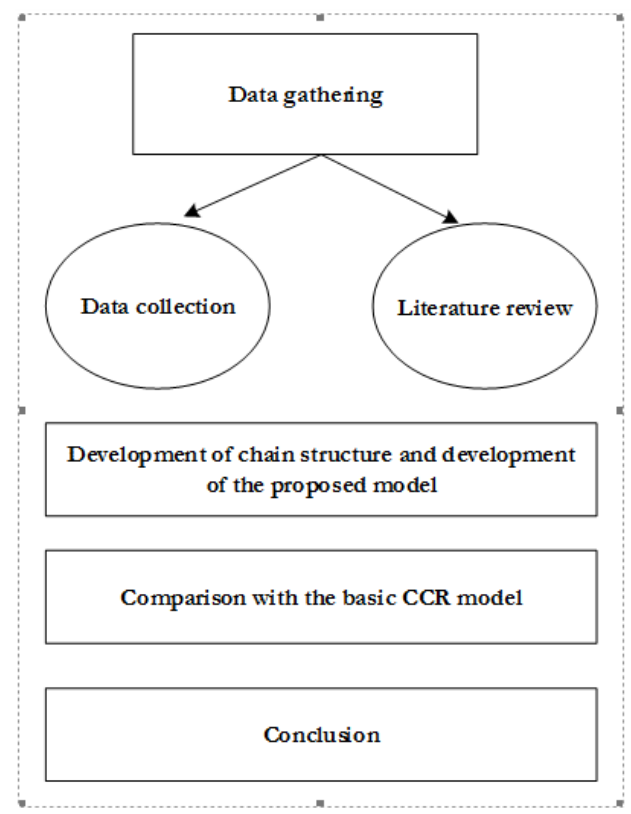
Fig. 1. Conceptual model of